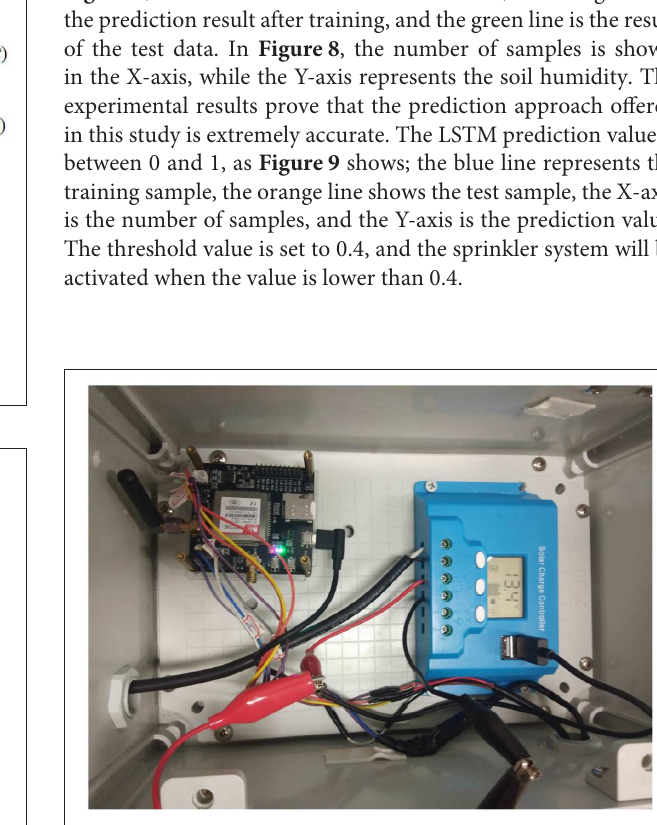
FIGURE 5 | Experimental hardware.